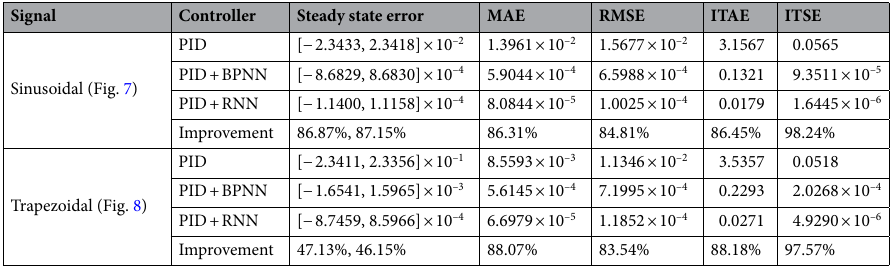
Table 4. Simulation comparisons of tracking sinusoidal and trapezoidal